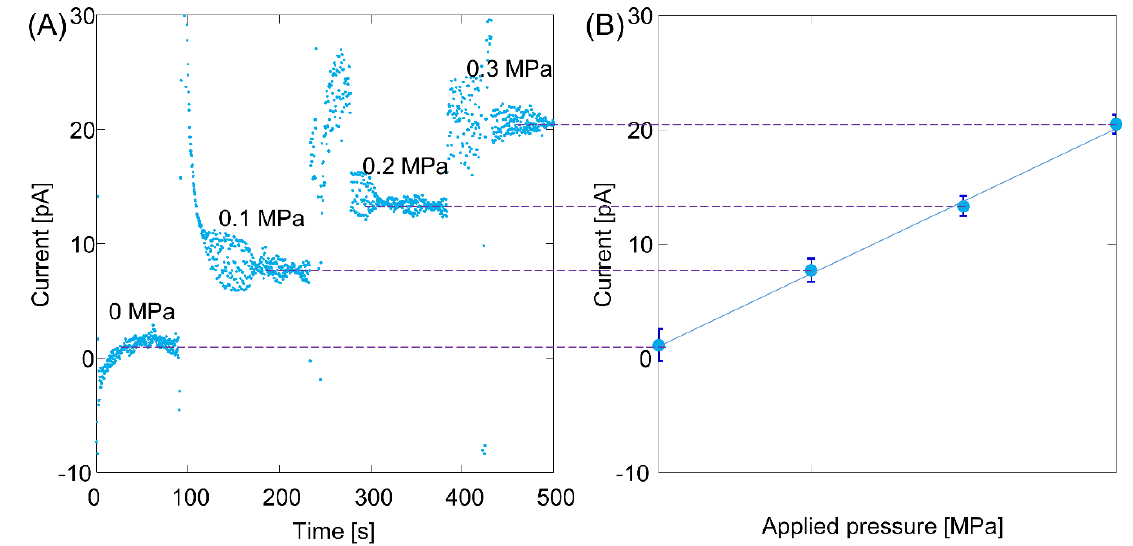
Figure 4. Streaming-current signals for unmodified nanochannel surface: ( A ) raw data for current signals and ( B ) pressure dependence of current.